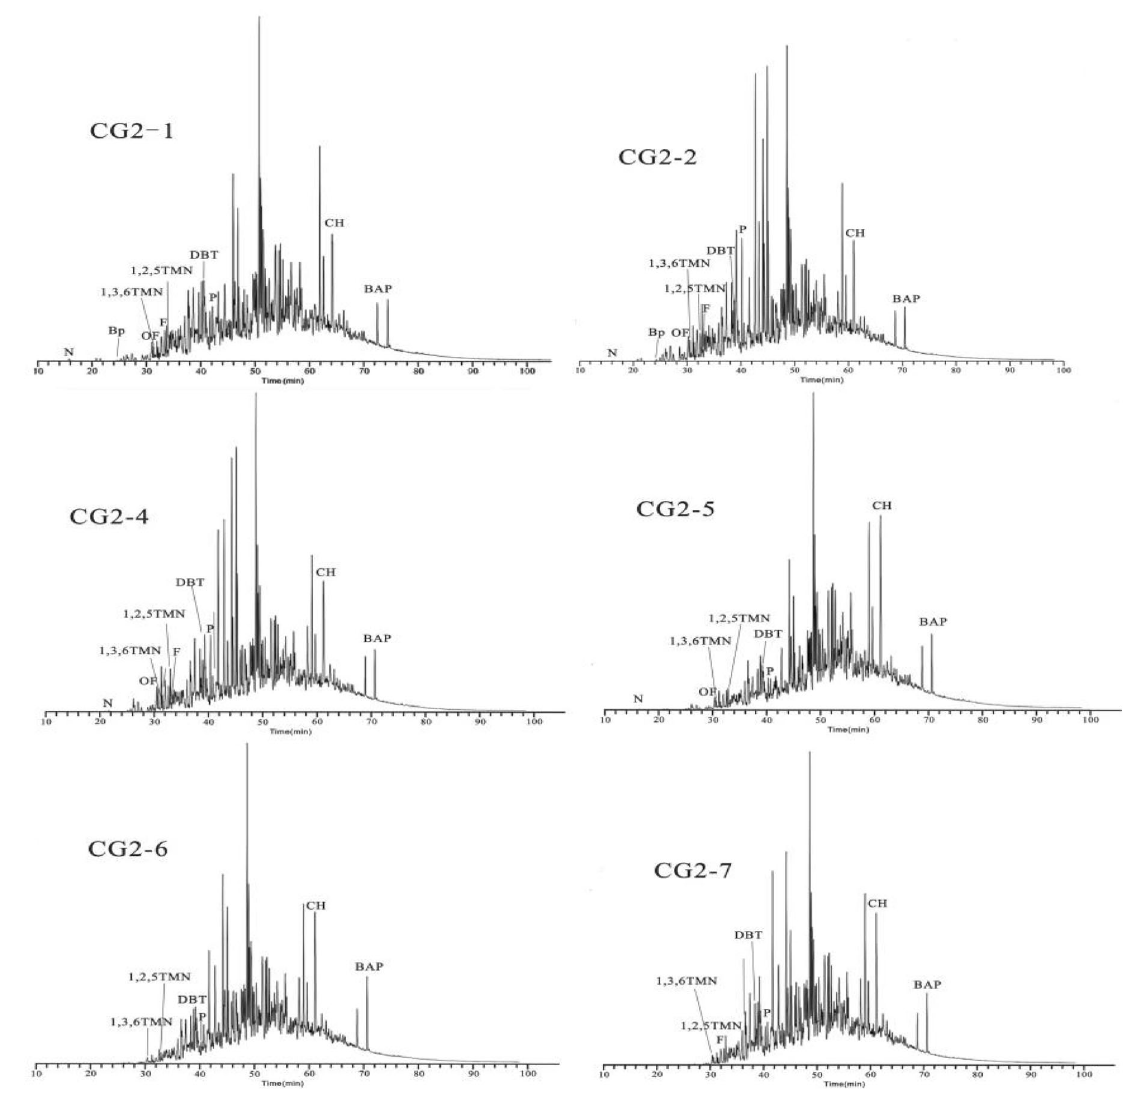
Fig. 3 Mass chromatograms of aromatic hydrocarbons for the samples used Table 3 Relative abundances of aromatic hydrocarbons and the ratios of biomarkers Sample Naphthalene series